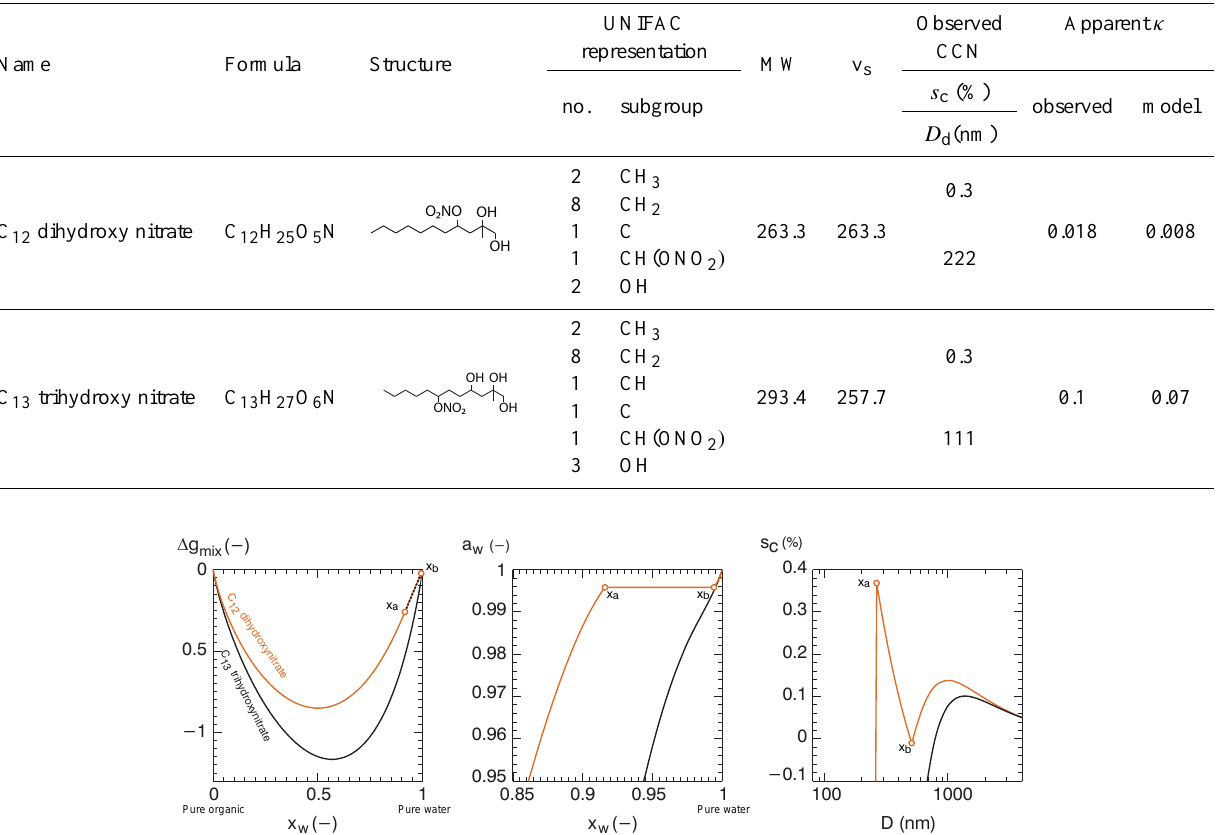
Table 1. Properties for two example chemical compounds. UNIFAC representation indicated the number and type of subgroups to represent the chemical structure: MW denotes molecular weight (gmol − 1 ) and v s denotes the model predicted molar volume (cm 3 mol − 1 ). CCN reflects the observed supersaturation and dry diameter data pair obtained from the source (Suda et al., 2014) from which observed κ was determined.